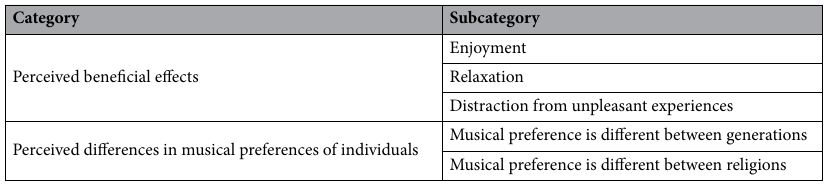
Table 5. Perception of music.